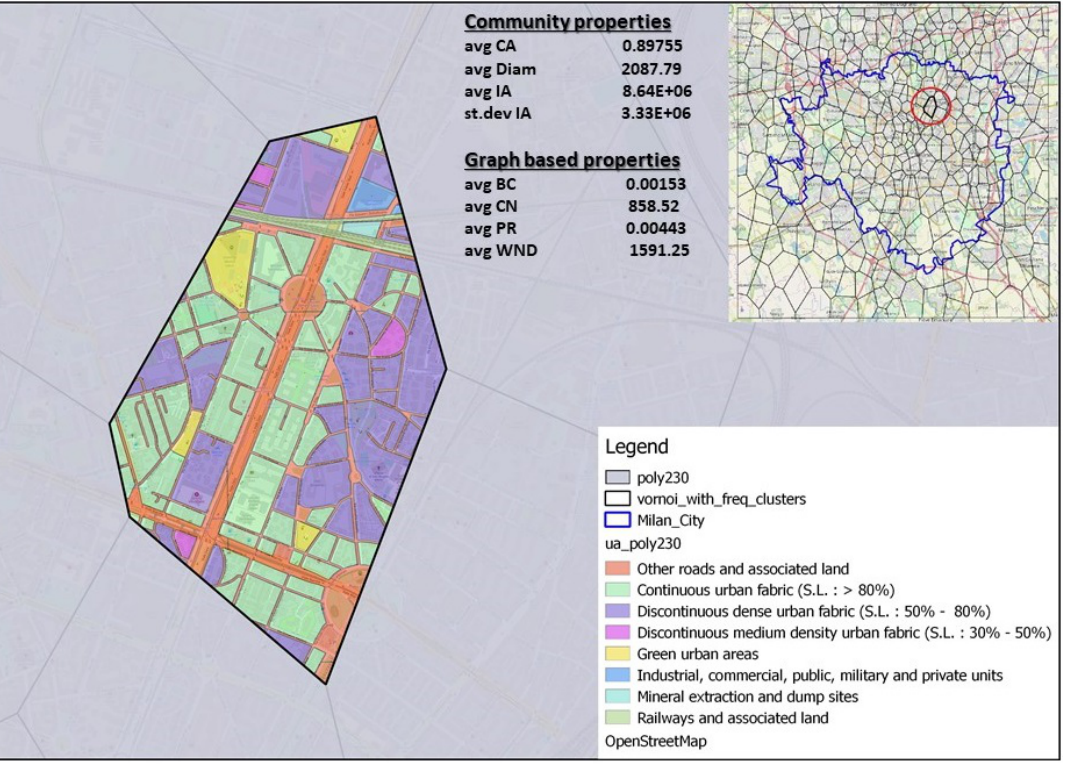
Figure 10. Land use profile of polygon where the dominant class is Other roads and associated land